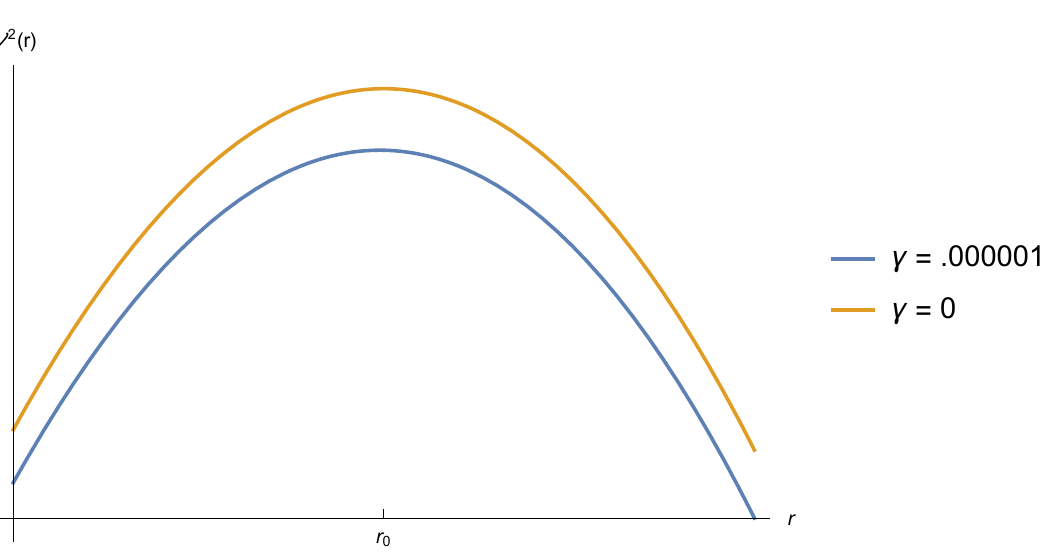
Figure 12. The square V 2 ( r ) of the volume functional for both the Weyl 4 -corrected AdS- Schwarzschild geometry and the uncorrected geometry. We have zoomed on the local maximum r (cid:3) to show that the correction in eq. (2.41) reduces _ C V , as